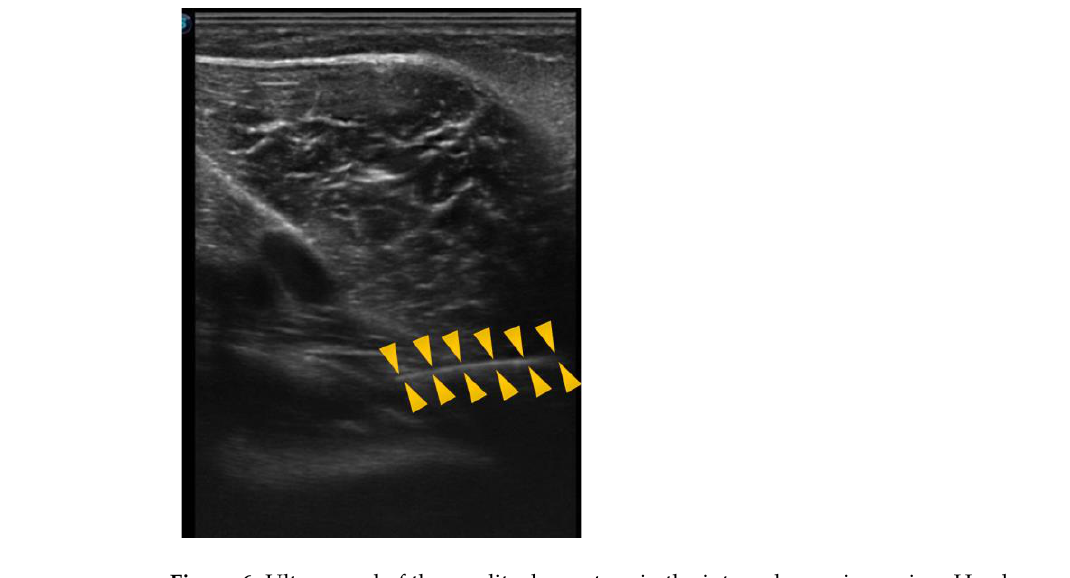
Table 2. Correlation between the BMI and the needle depth.